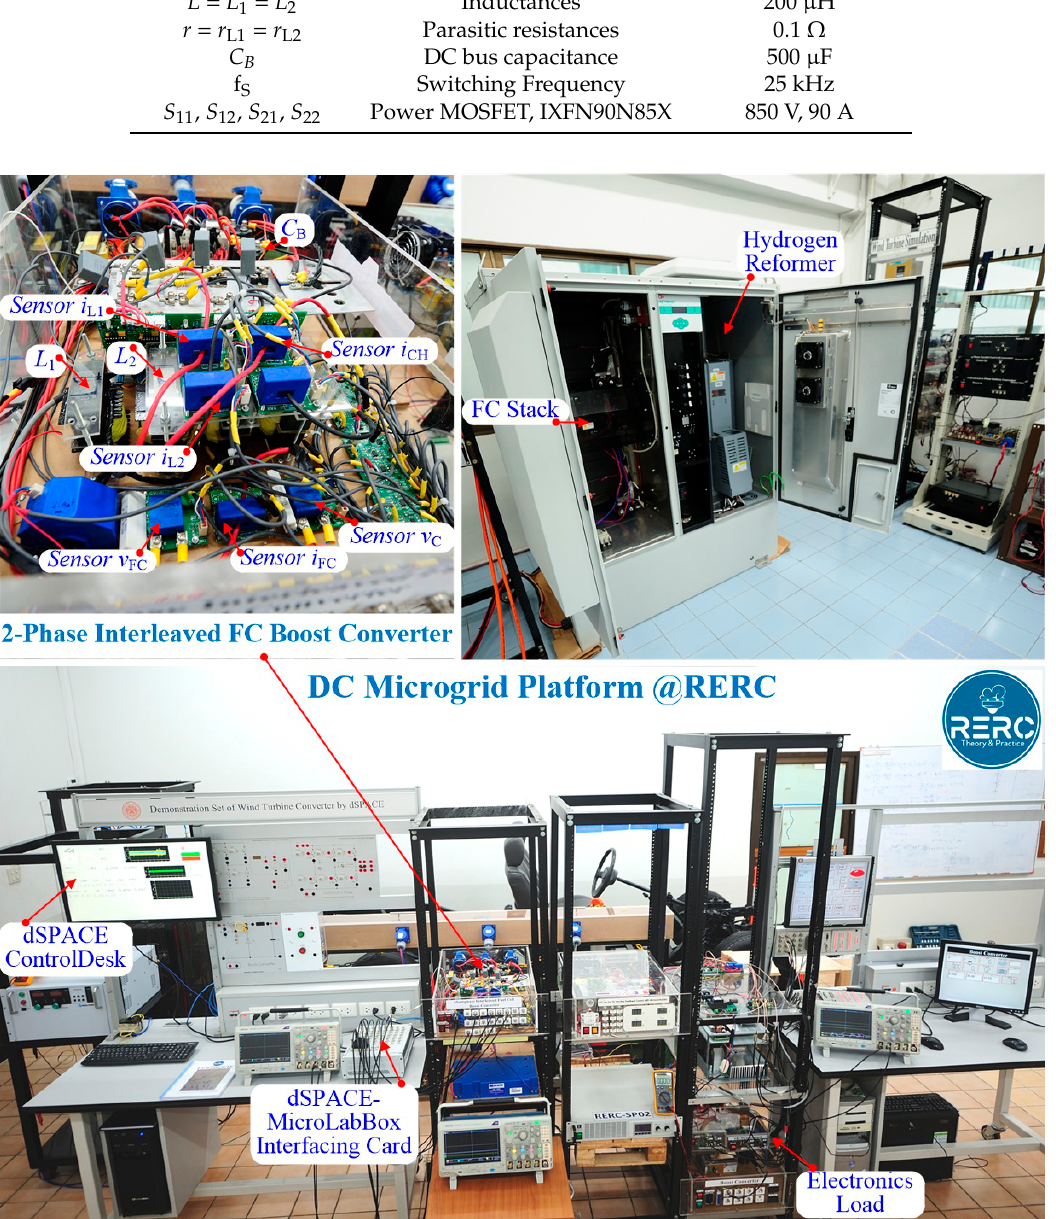
Figure A1. Overview of the DC microgrid platform realized in the laboratory (Renewable Energy Research Centre RERC, Bangkok, Thailand). Table A2. Controller parameters.